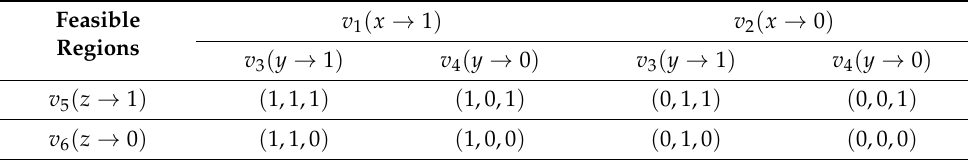
Table 3. Evolutionary stable strategies for feasible regions under each combination. Feasible